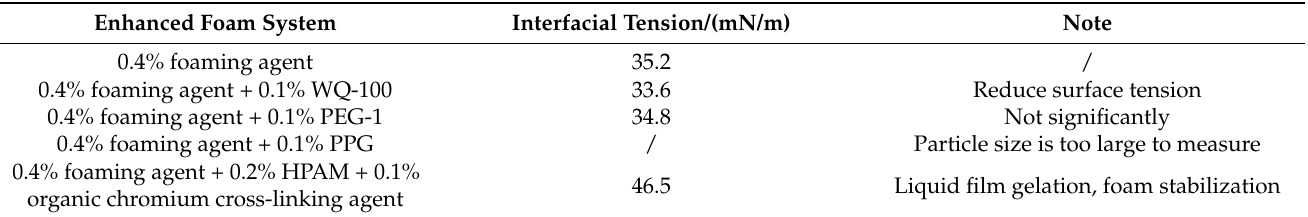
Table 1. The formula of enhanced foam system with pre-crosslinking gel